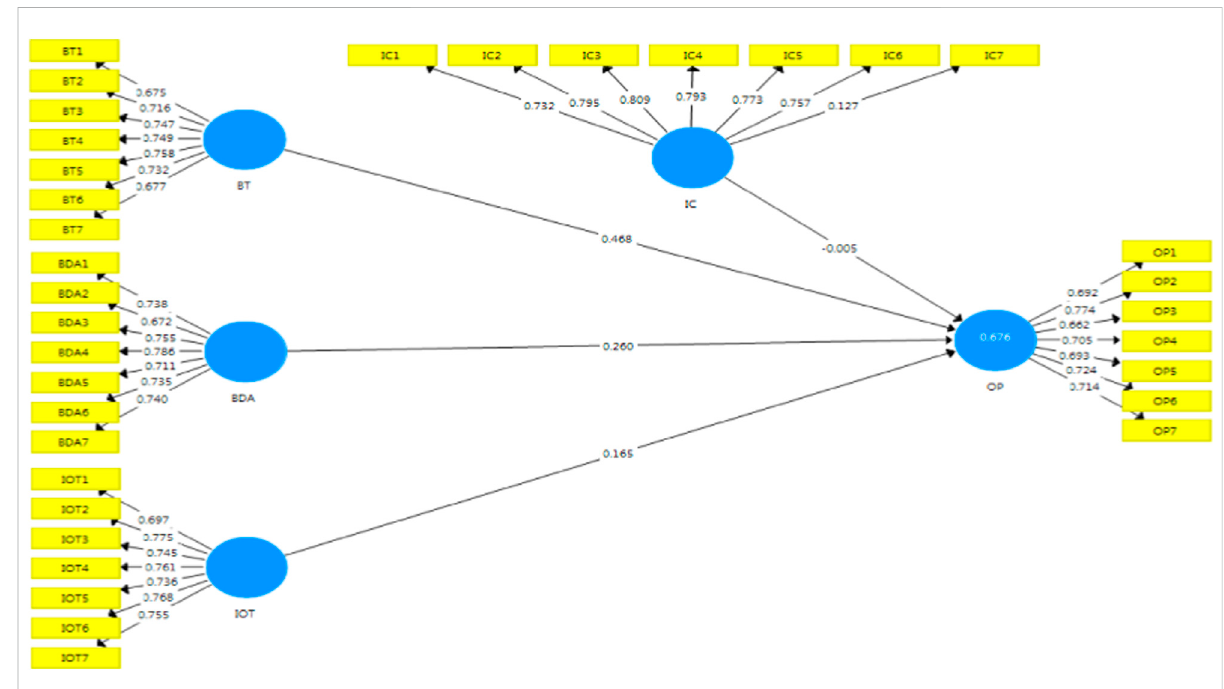
FIGURE 2 PLS algorithm direct